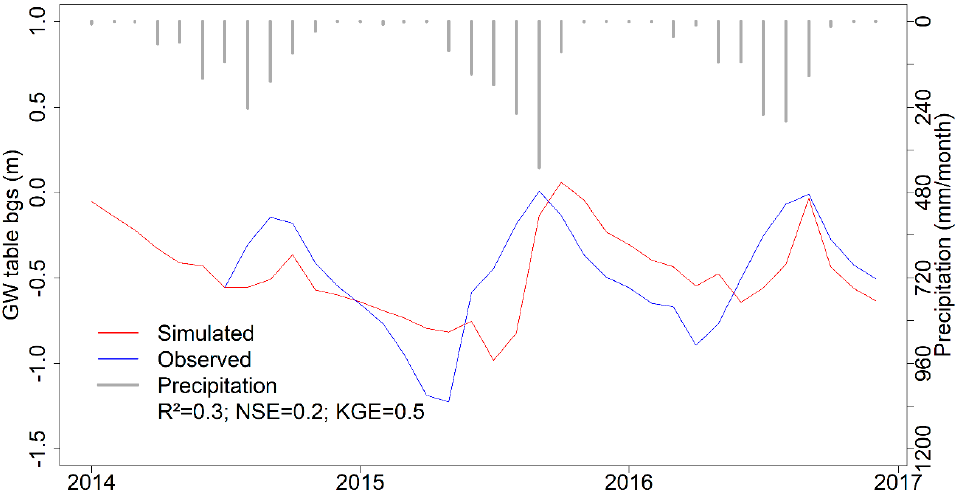
Figure 10. Comparison of the monthly areal average of the simulated groundwater table below the ground surface (bgs) at the downstream sub-catchment (Lo ffi ng) and the observed groundwater level at a piezometer located at the outlet of the